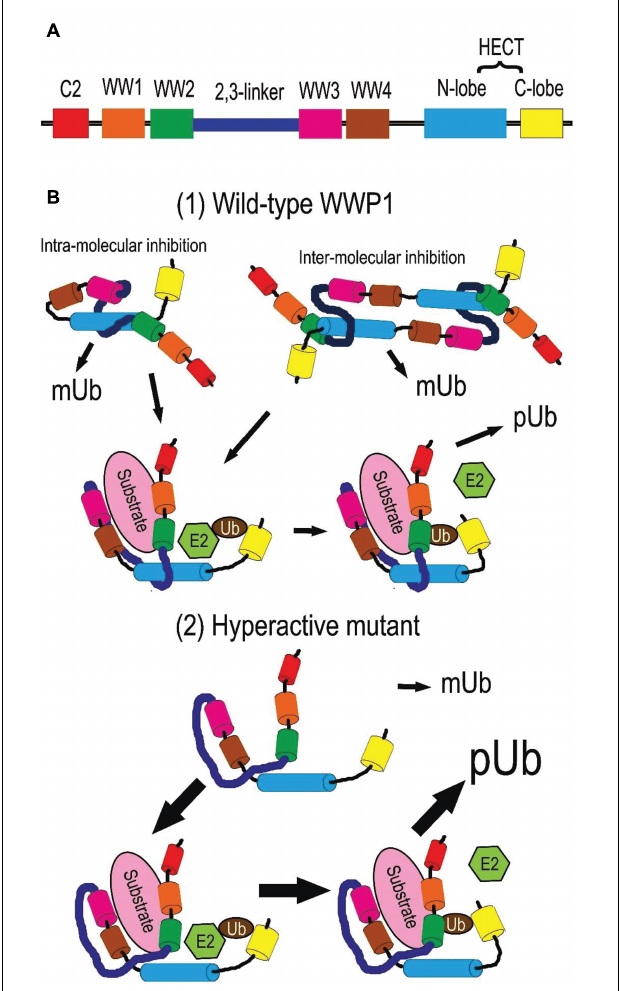
FIGURE 2 | Protein structure and activity regulation of WWP1. (A) Depiction of WWP1 protein structure. Each domain is depicted in a certain color (the same below). (B) Activity regulation of WWP1. (1) Wild-type WWP1 is autoinhibited via intra- or inter-molecular interactions in a steady state: